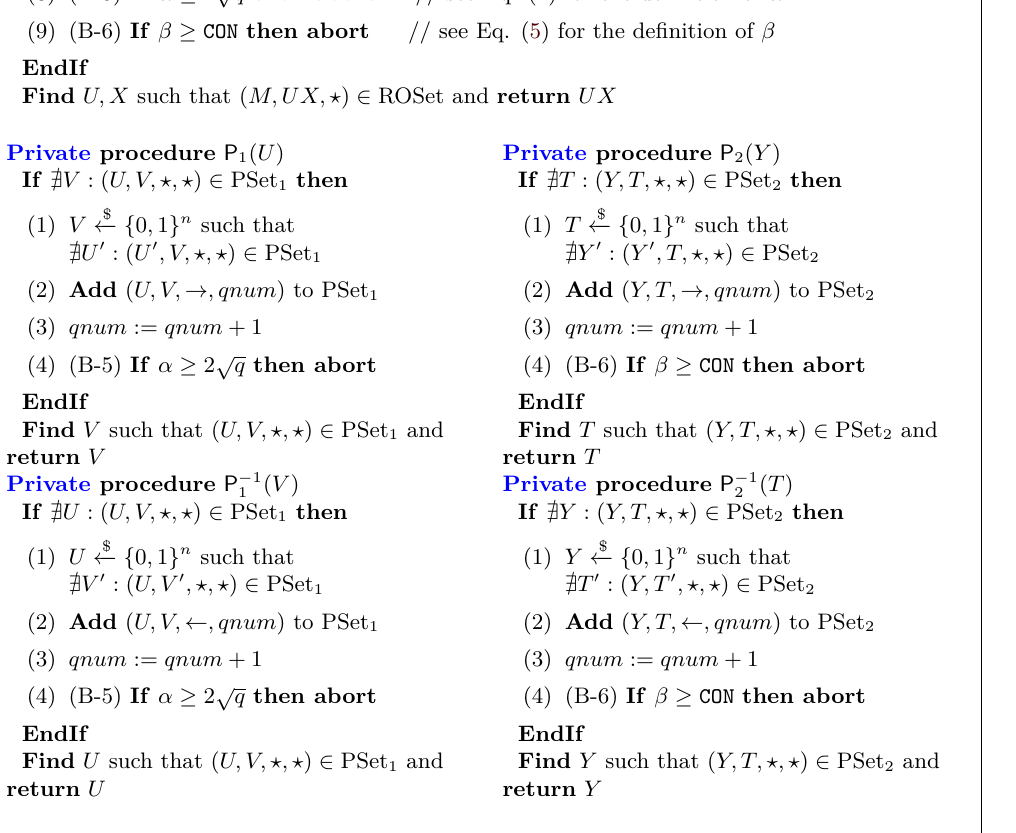
Figure 3: Security game capturing the interaction between A and the idealized tag generation and verification oracles of LRWHM